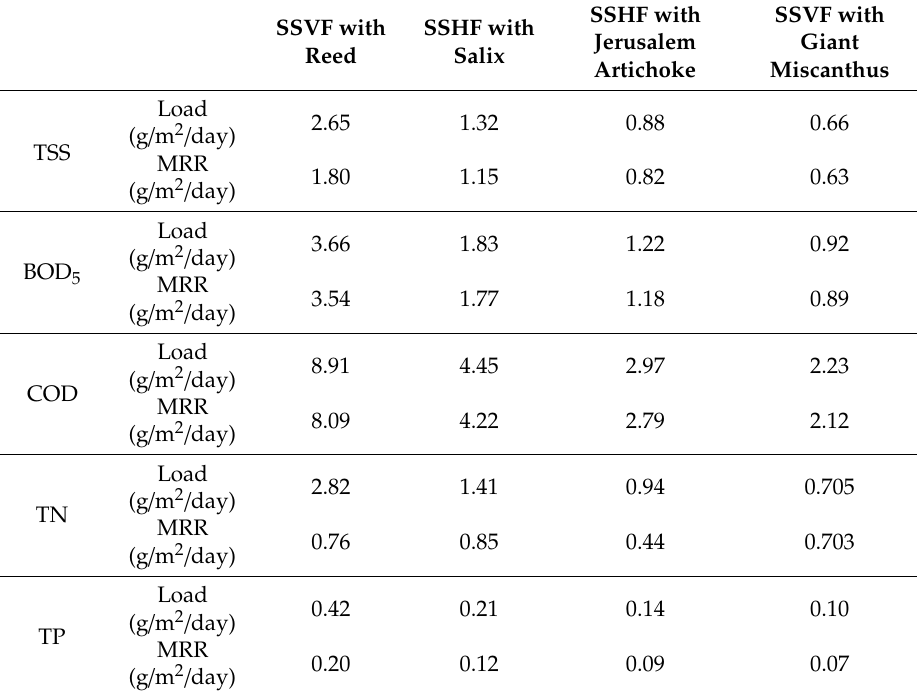
Table 4. Mass removal rates (MRR) of BOD 5 , COD, TN and TP. SSHF with SSVF with SSHF with Jerusalem Reed Salix Artichoke